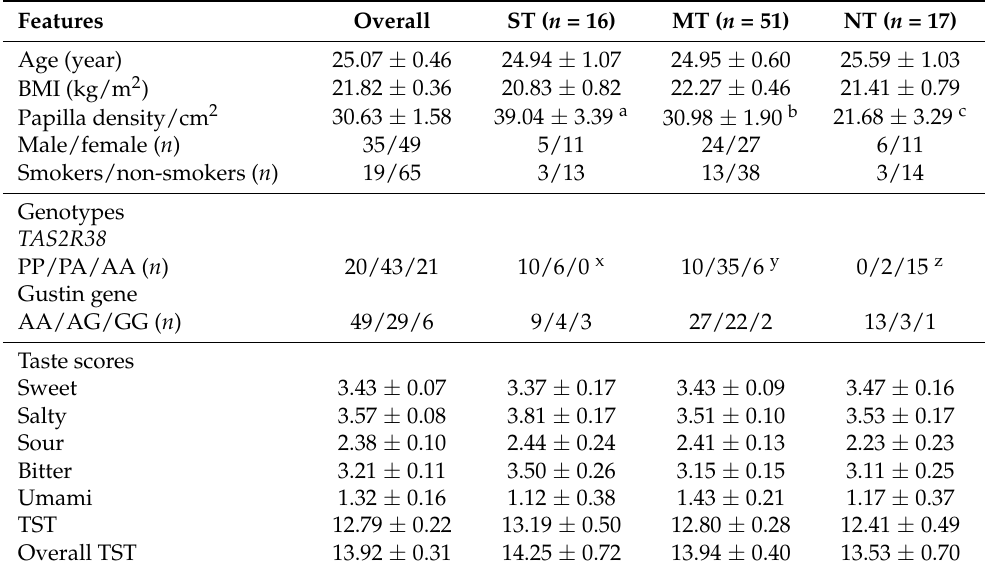
Table 1. Demographic, clinical, morphological, genetic, and sensory features of subjects according to PROP taster